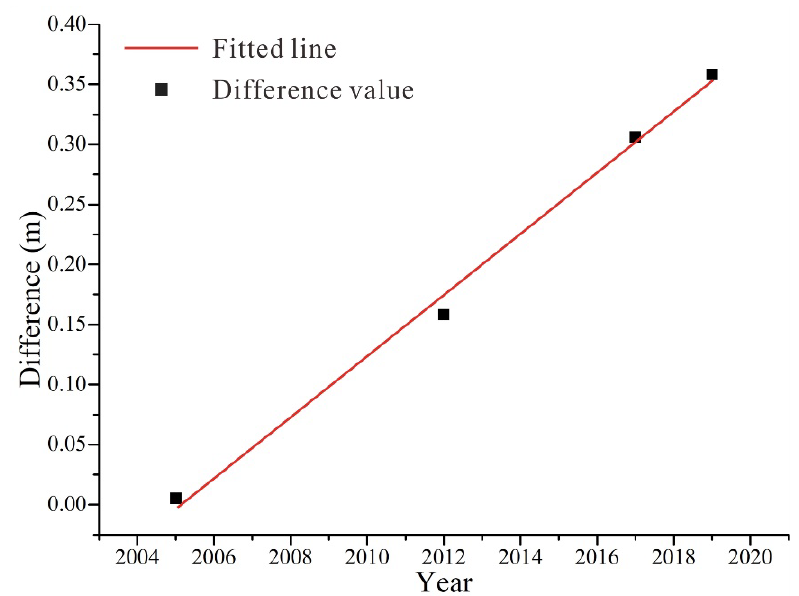
Figure 9. Fitting curve for the difference between the measured value and the simulated value.